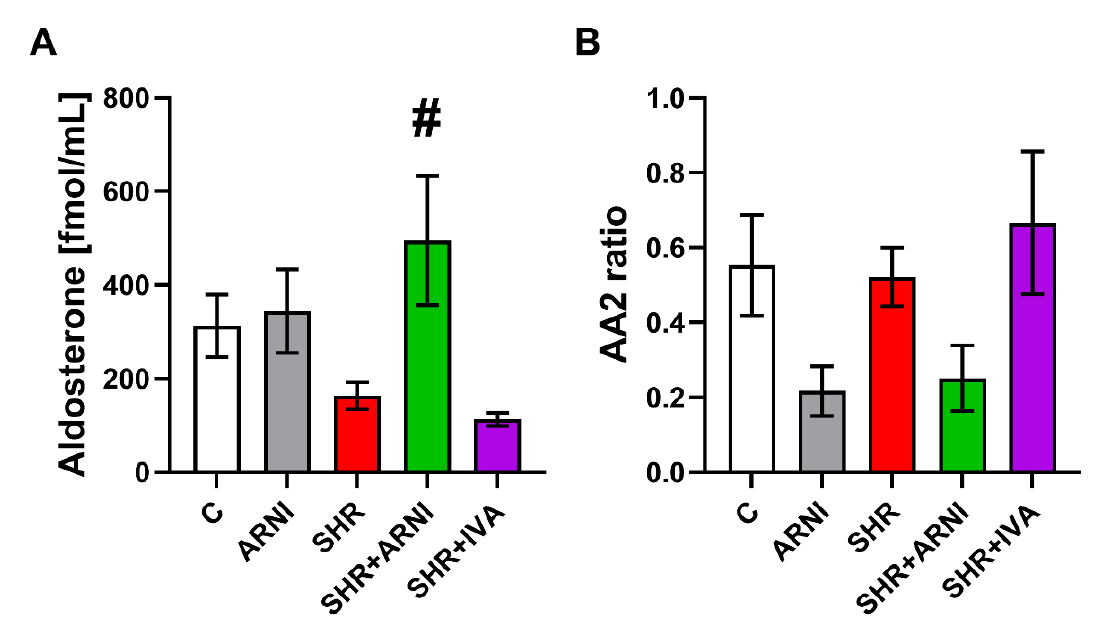
Figure 5. Effect of ARNI and ivabradine on the serum level of aldosterone ( A ) and the aldosterone/angiotensin II ratio (AA2 ratio) ( B ) in SHRs after six weeks of treatment. ARNI, sacubitril/valsartan; C, Wistar controls; IVA, ivabradine; SHRs, spontaneously hypertensive rats. Results are presented as means ± SEM. n = 6 per group. One-way, two-tailed ANOVA followed by multiple comparisons with a Bonferroni post-hoc test; # p < 0.05 vs. SHR.